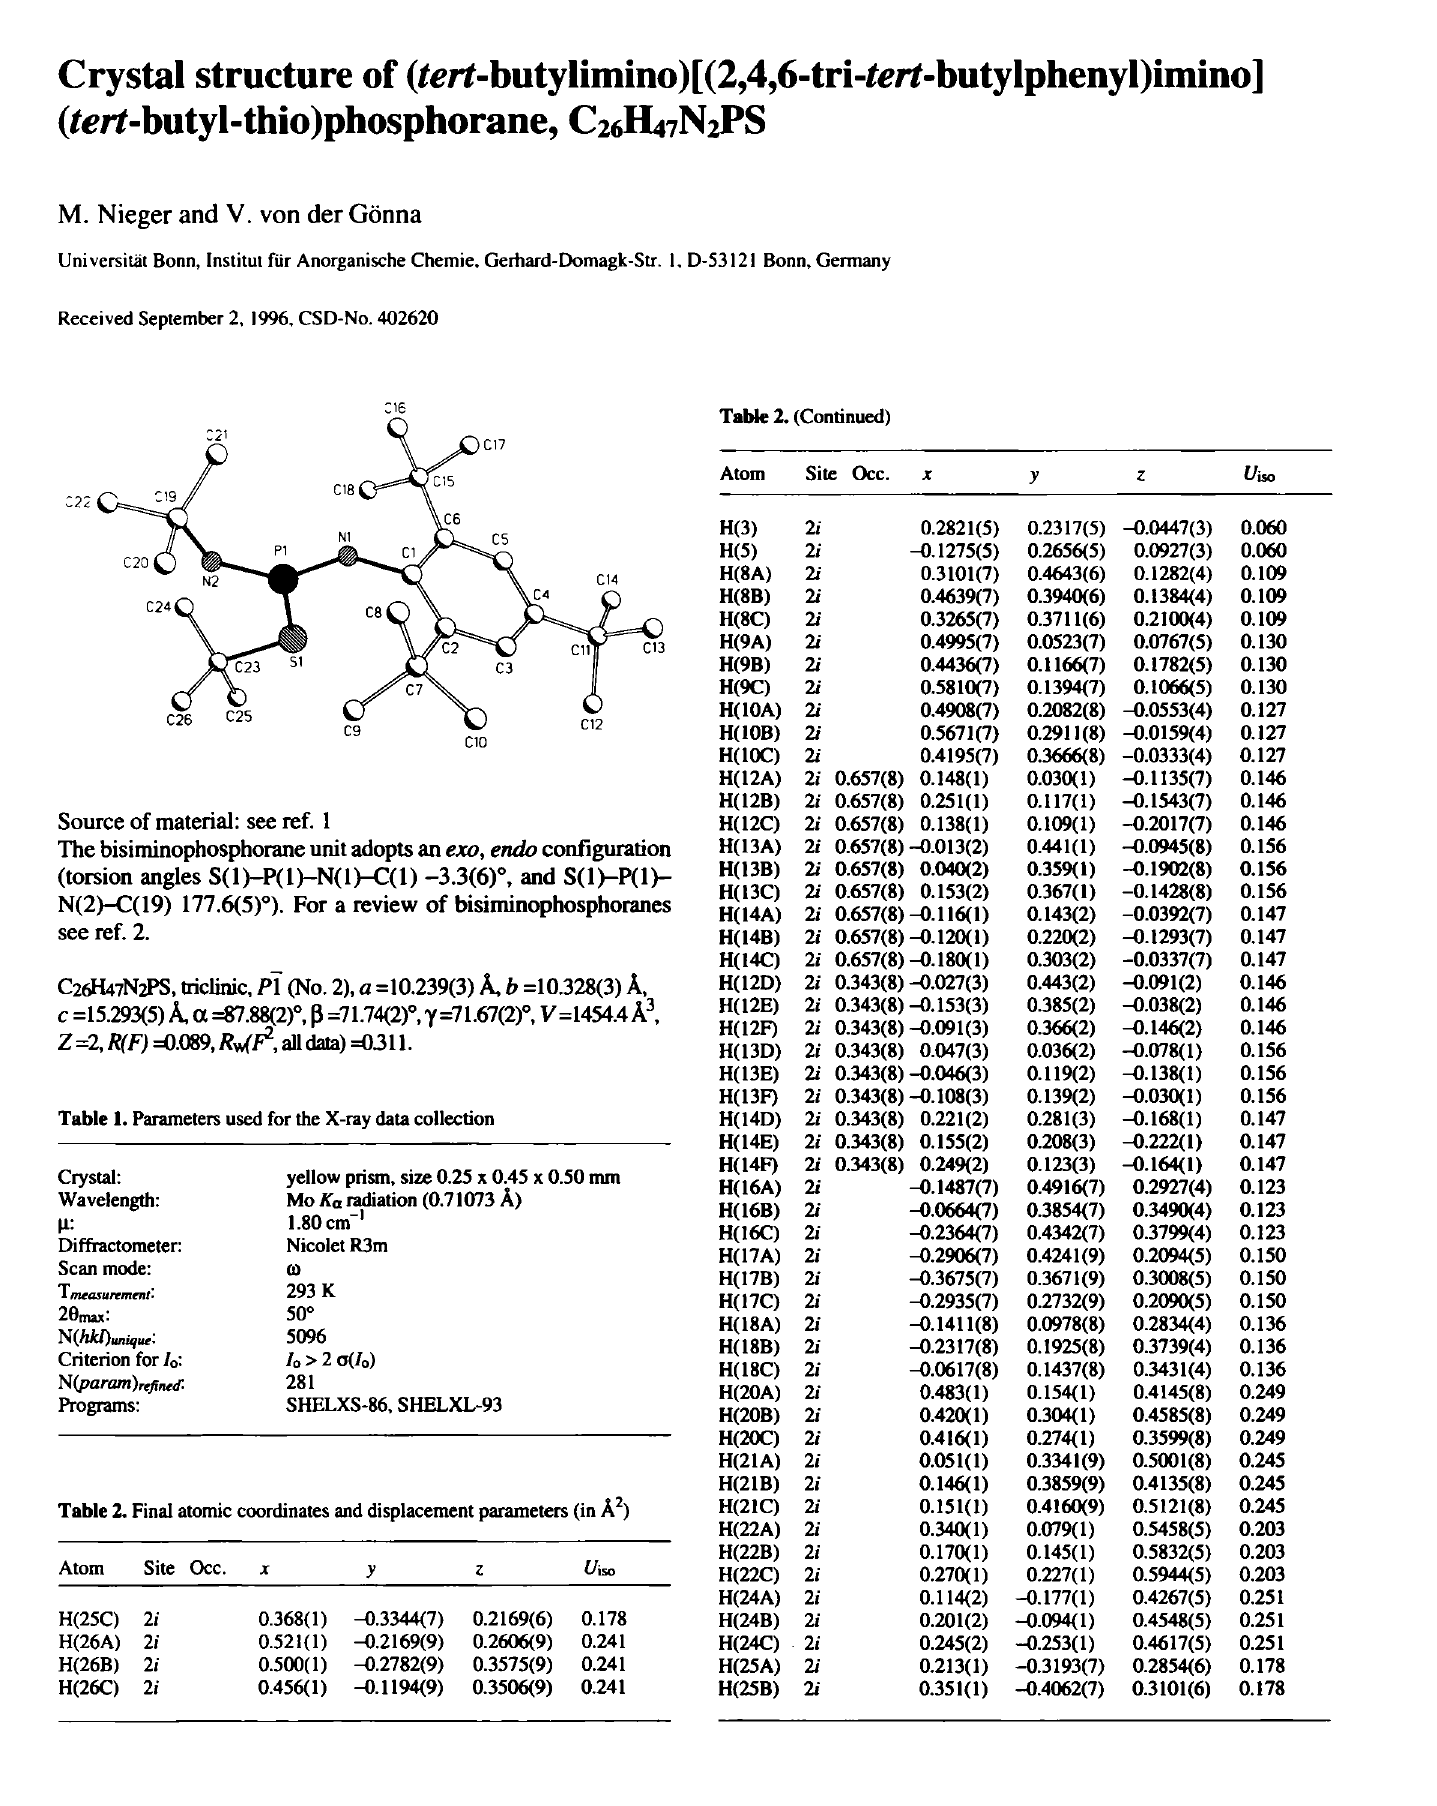
Table 2. Final atomic coordinates and displacement parameters (in Â 2 ) Atom Site